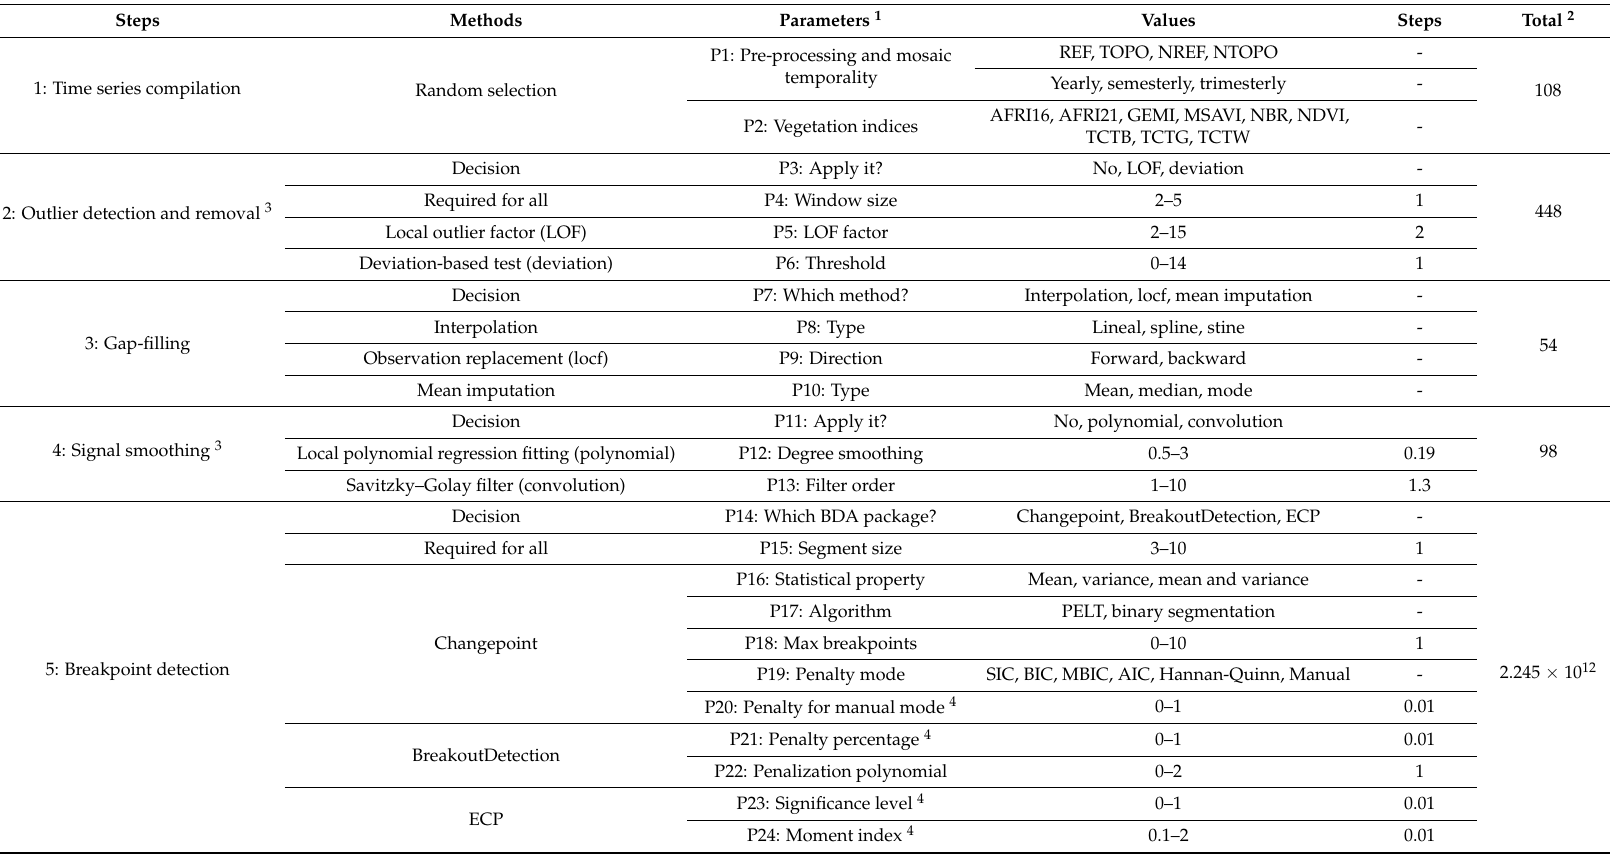
Table 3. Summary of PCG steps, methods, algorithms, packages, parameters, values, steps, and their search space